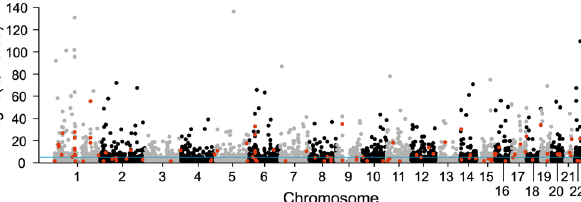
Figure 1. Manhattan plot of the eQTL mega-analysis in liver. A mega-analysis was conducted including 588 samples from four independent studies measuring eQTL variants in liver tissue. The Manhattan plot shows the − log 10 Q-Values of the most significant variant for each of the 24,123 analysed autosomal genes. Additionally, 101 independent secondary signals were identified and are highlighted in red. The blue line depicts the threshold for significance at 1 × 10 − 3